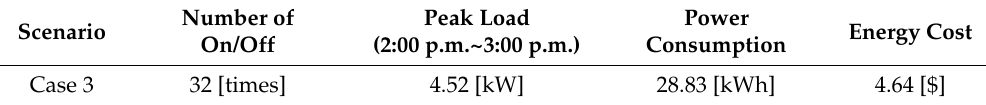
Table 8. Scenarios for ESS simulation